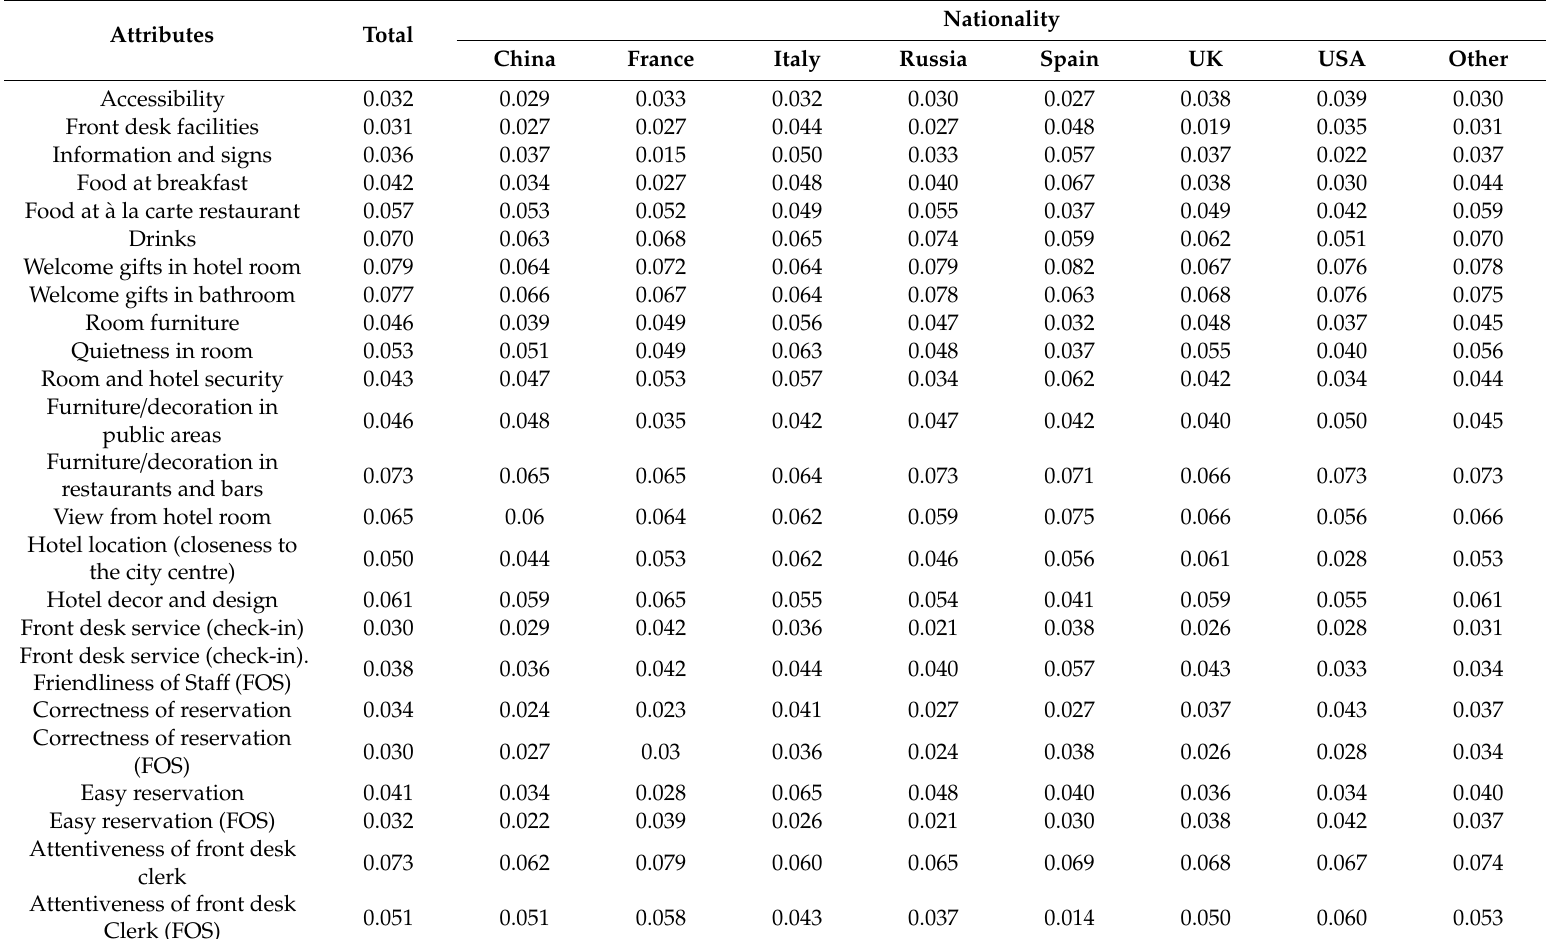
Table A2. Elasticities of Guests’ Satisfaction. Total and nationality. Three-Star